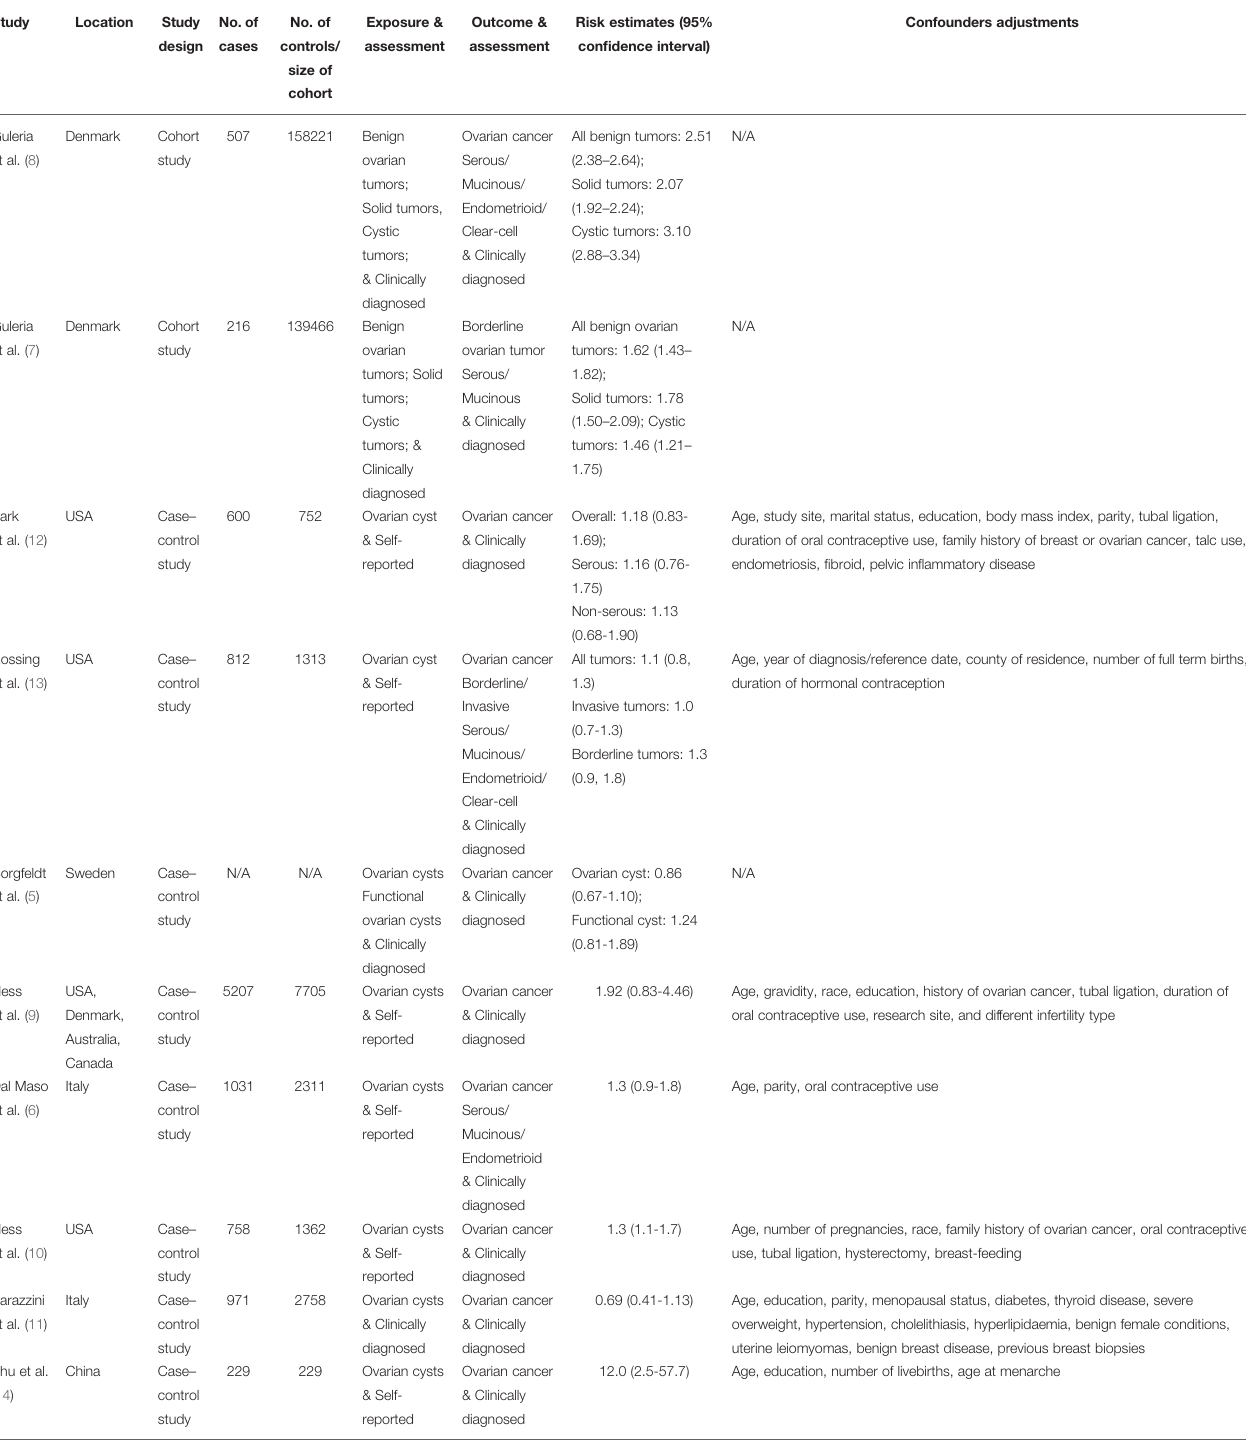
TABLE 1 | Characteristics of studies included in the